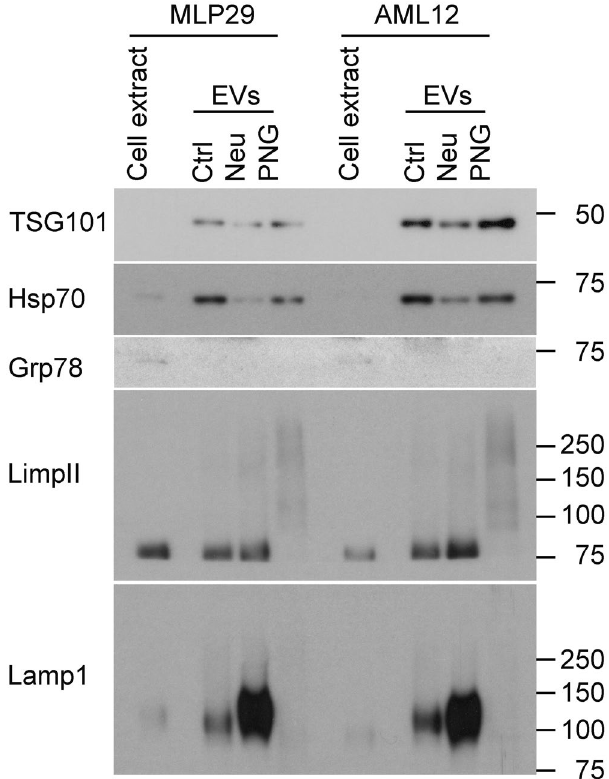
Figure 3. Western blot analysis of native and glycosidase-treated EVs. Cell extracts and EVs were analysed by Western-blotting using antibodies against non-EV (Grp78), EV (Tsg101, Hsp70, LimpII, Lamp1) proteins. Note changes in the detection of glycosylated membrane proteins (LimpII and Lamp1) due to glycosylation treatments. This figure has been composited from a single membrane stained multiple times, with individual images available in Supplementary